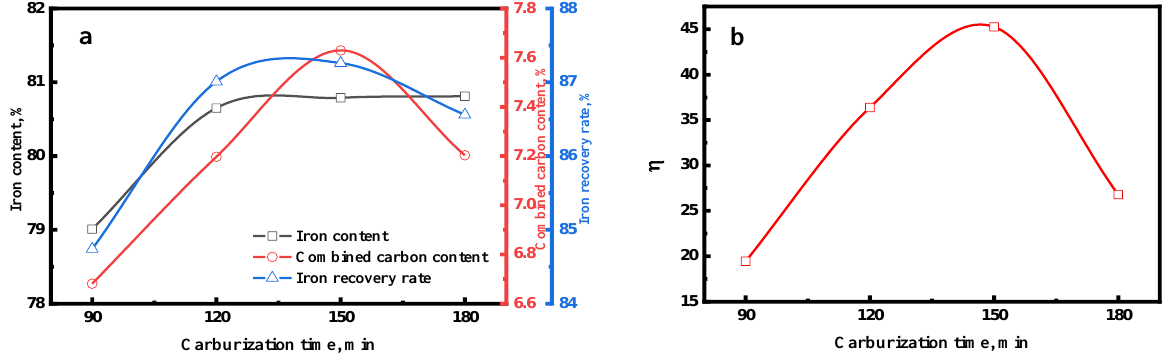
Figure 10. Effect of carburization time on the ( a ) magnetic concentrate and ( b ) carburization index of carburized pellet (carburized at 700 °C min with 20% Na 2 SO 4 ).